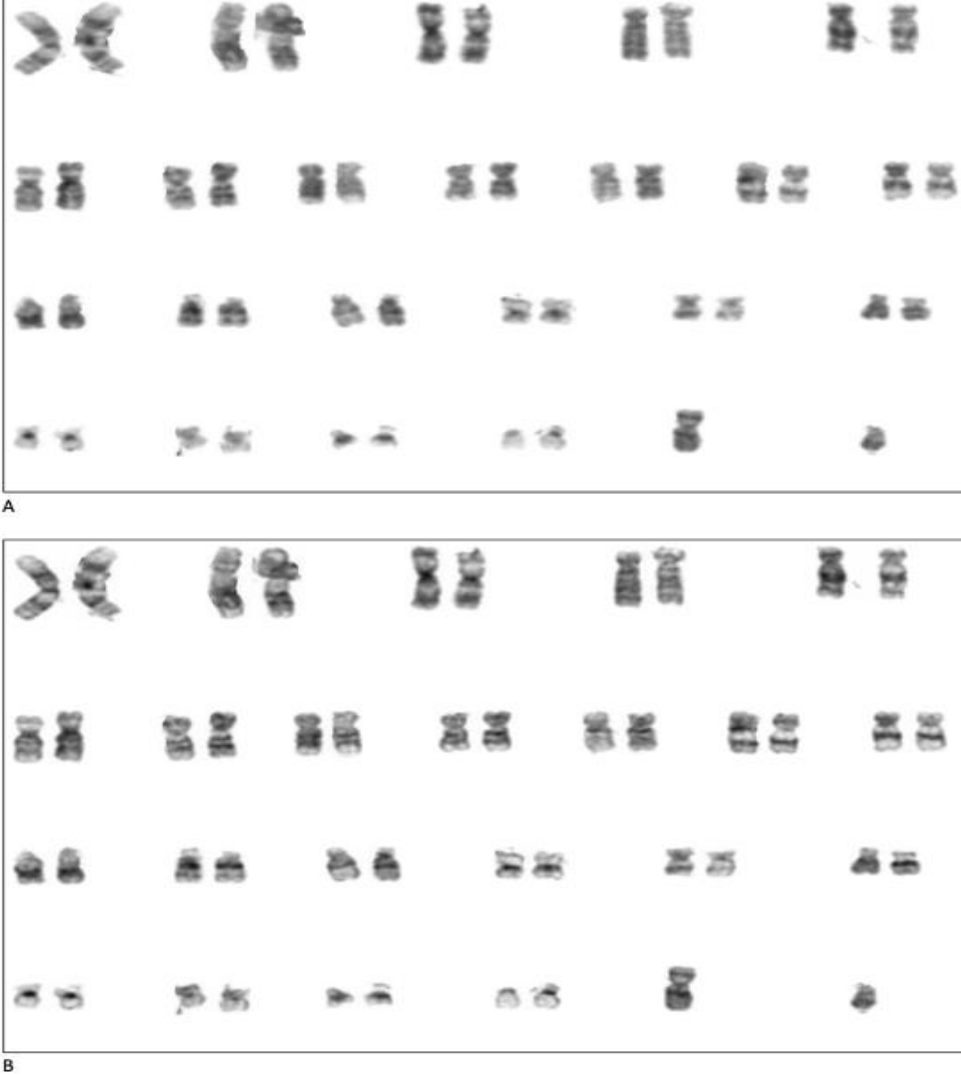
Figure 4. Example of whole karyogram enhancement. ( A ) Original karyogram taken from cytogenetics state of the art system, ( B ) enhanced karyogram by ChromoEnhancer.